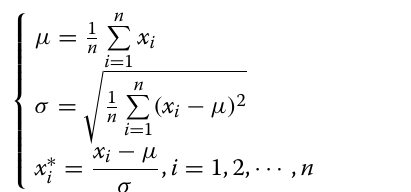
Table 1 Adopted values for each parameters of PERBPNN Parameter Values Hidden layers 3 Neurons Learning rate 0.001 Learning decay rate 0.2 Activation function ReLU Optimizer Adam